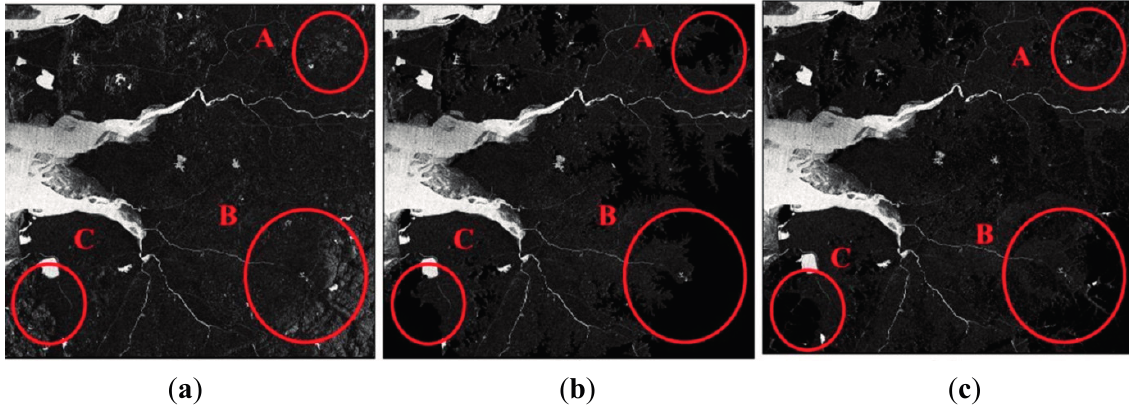
Figure 6. The water classification results of: ( a ) Case #1; ( b ) Case #2; ( c ) Case